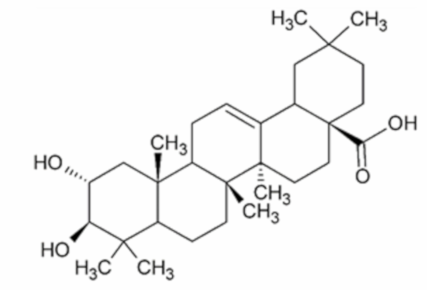
Figure 1. Chemical structure of maslinic